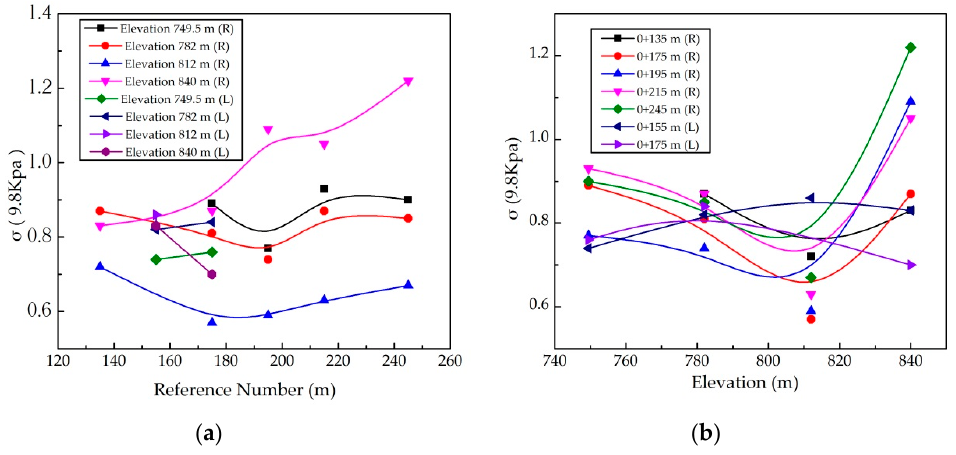
Figure 9. The RMS values σ of fluctuating pressure histories on slope protection plates under operating Condition 2. ( a ) along reference numbers; and ( b ) along elevation.